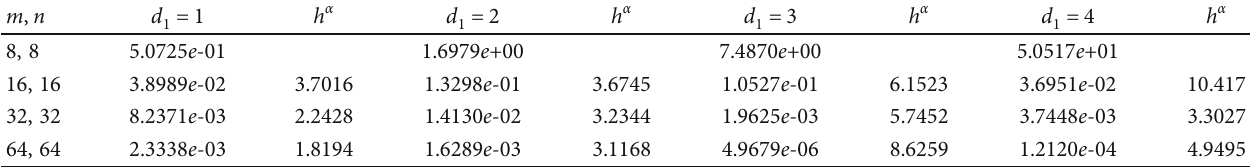
= 7 at t = 1 for equidistant nodes. 2